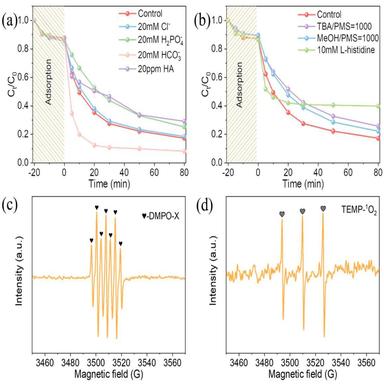
(a) The anions and natural organic matter effects Cl– , H2PO4 – , HCO3 – and HA; (b) effect of quenching scavengers on TTCH degradation in EMFe0.2S/PMS system; The DMPO-EPR (c) and the TEMP-EPR spectra of catalyst EMFe0.2S/PMS; Reaction conditions: = 20 ppm, = 0.15 g L− 1 , = 0.15 g L− 1 , and T = 25 ◦C.